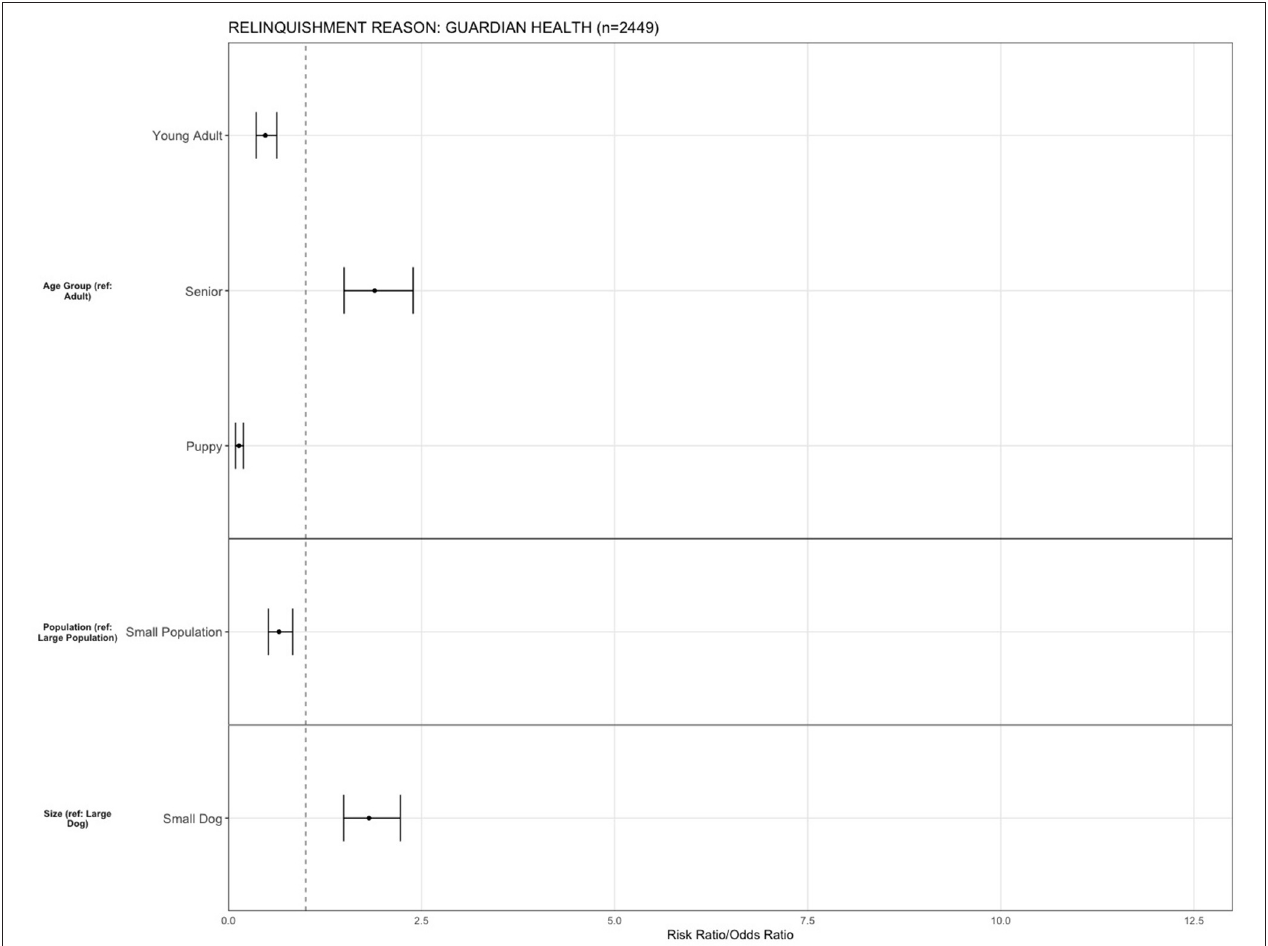
FIGURE 9 | The association between relinquishment reason and animal characteristics for puppies and dogs relinquished for the reason of “guardian health” ( n = 2,449). Characteristics include age group, Asilomar Accords category, breed type, dog size, sex, population center size, and year. The results of the logistic regression model are shown. Data are presented by risk ratios and their 95% confidence interval (bars); p < 0.05 when 95% confidence interval does not cross the vertical dotted line. A risk ratio > 1 suggests an increased risk of relinquishment of that the characteristic category, while a risk ratio < 1 suggests a reduced risk. Non-statistically significant results are excluded from the